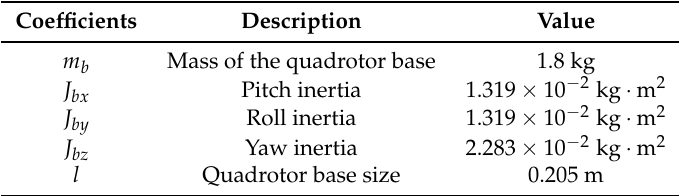
Table 1. Quadrotor base coefficients used in